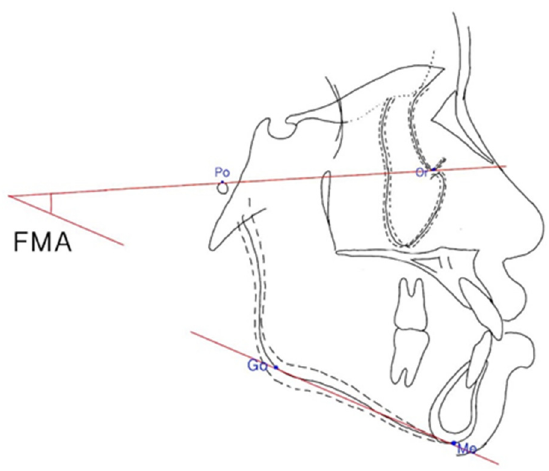
Figure 4. Frankfort–mandibular plane angle (FMA). The FMA was constructed by the intersection of the Frankfort horizontal plane and the mandibular plane.